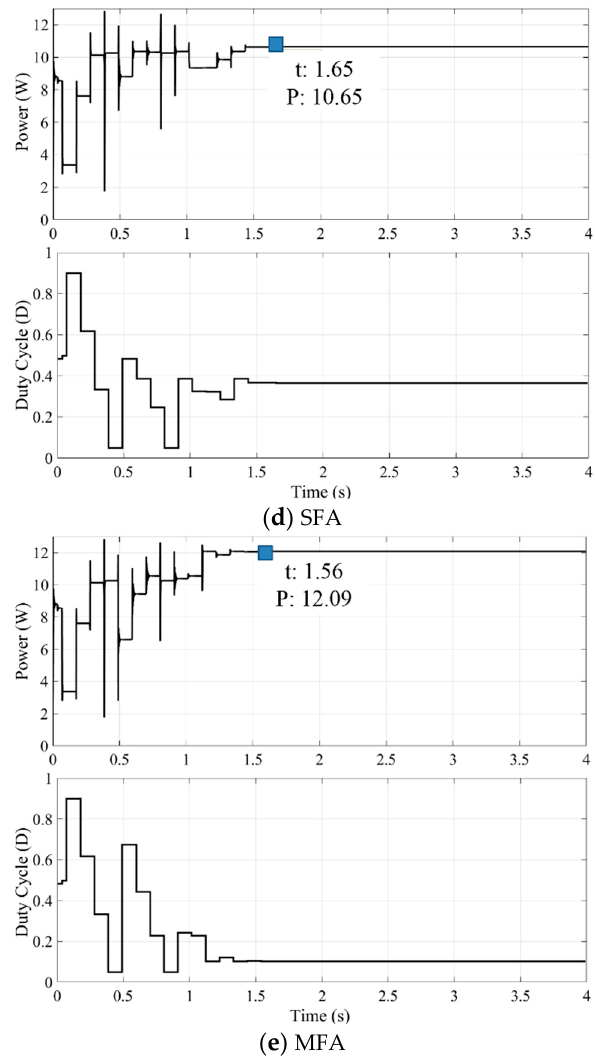
Figure 14. Power and duty cycle variations during one simulated tracking process for the five algorithms under PSC Pattern #10.